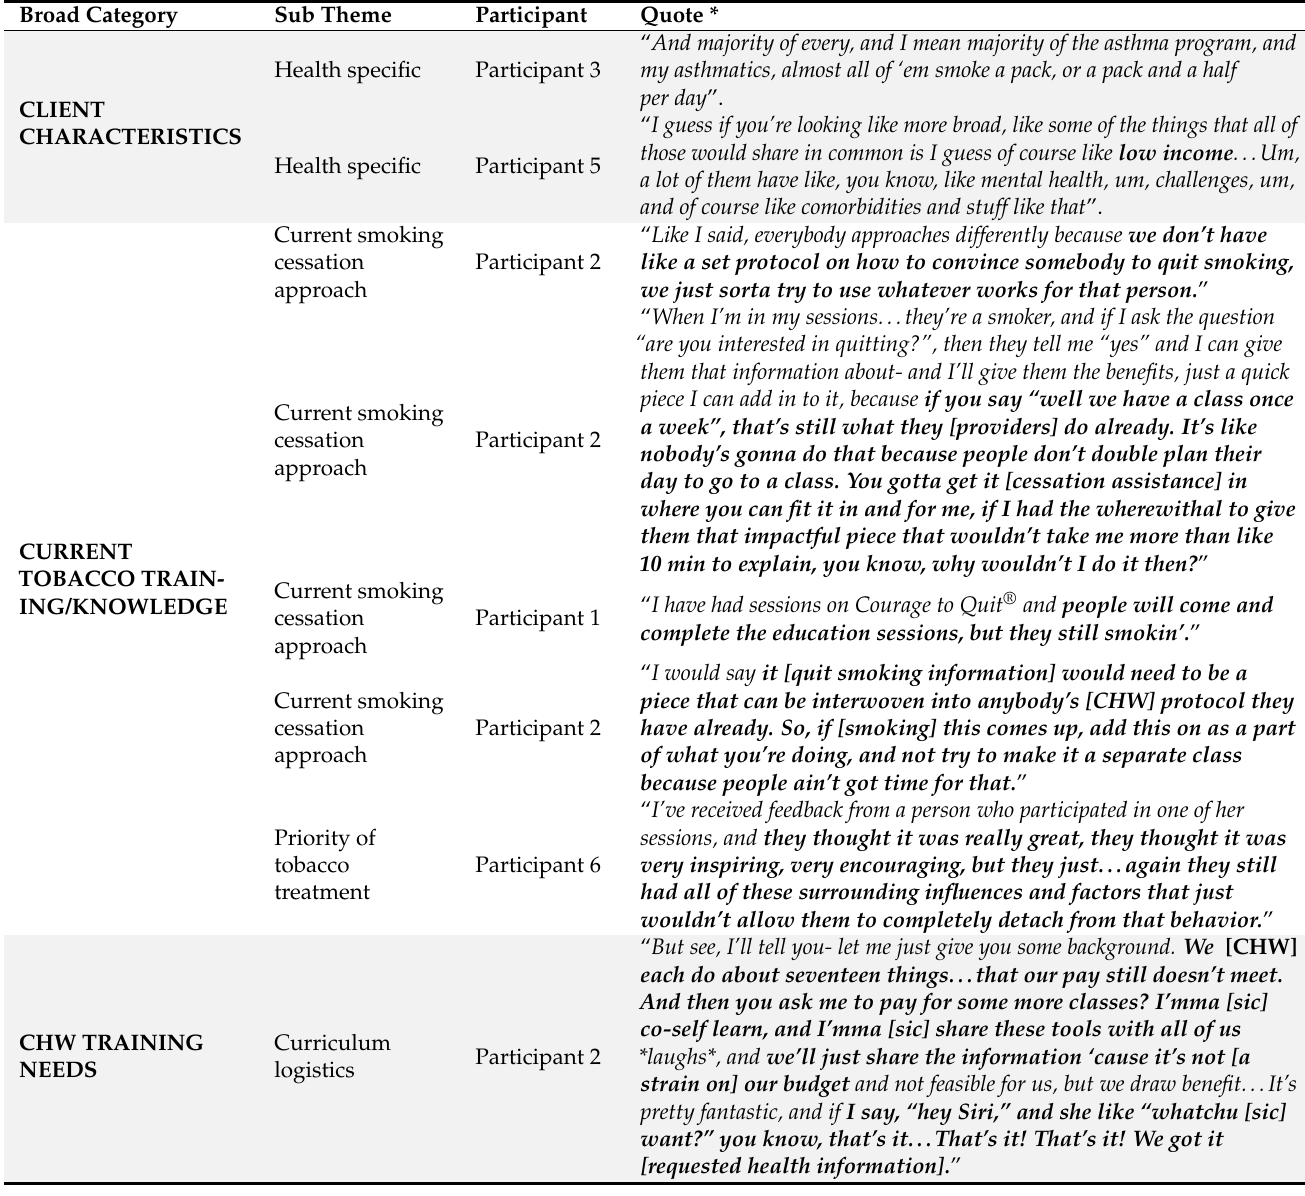
Table A2. Major themes related to Community Health Worker (CHW) tobacco cessation training